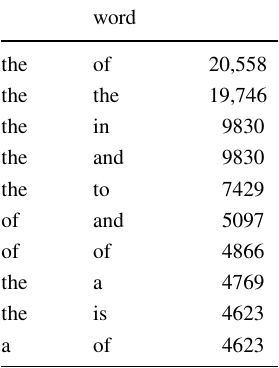
Table 3 Illustration of top 10 most common word–context pairs on the first 500,000